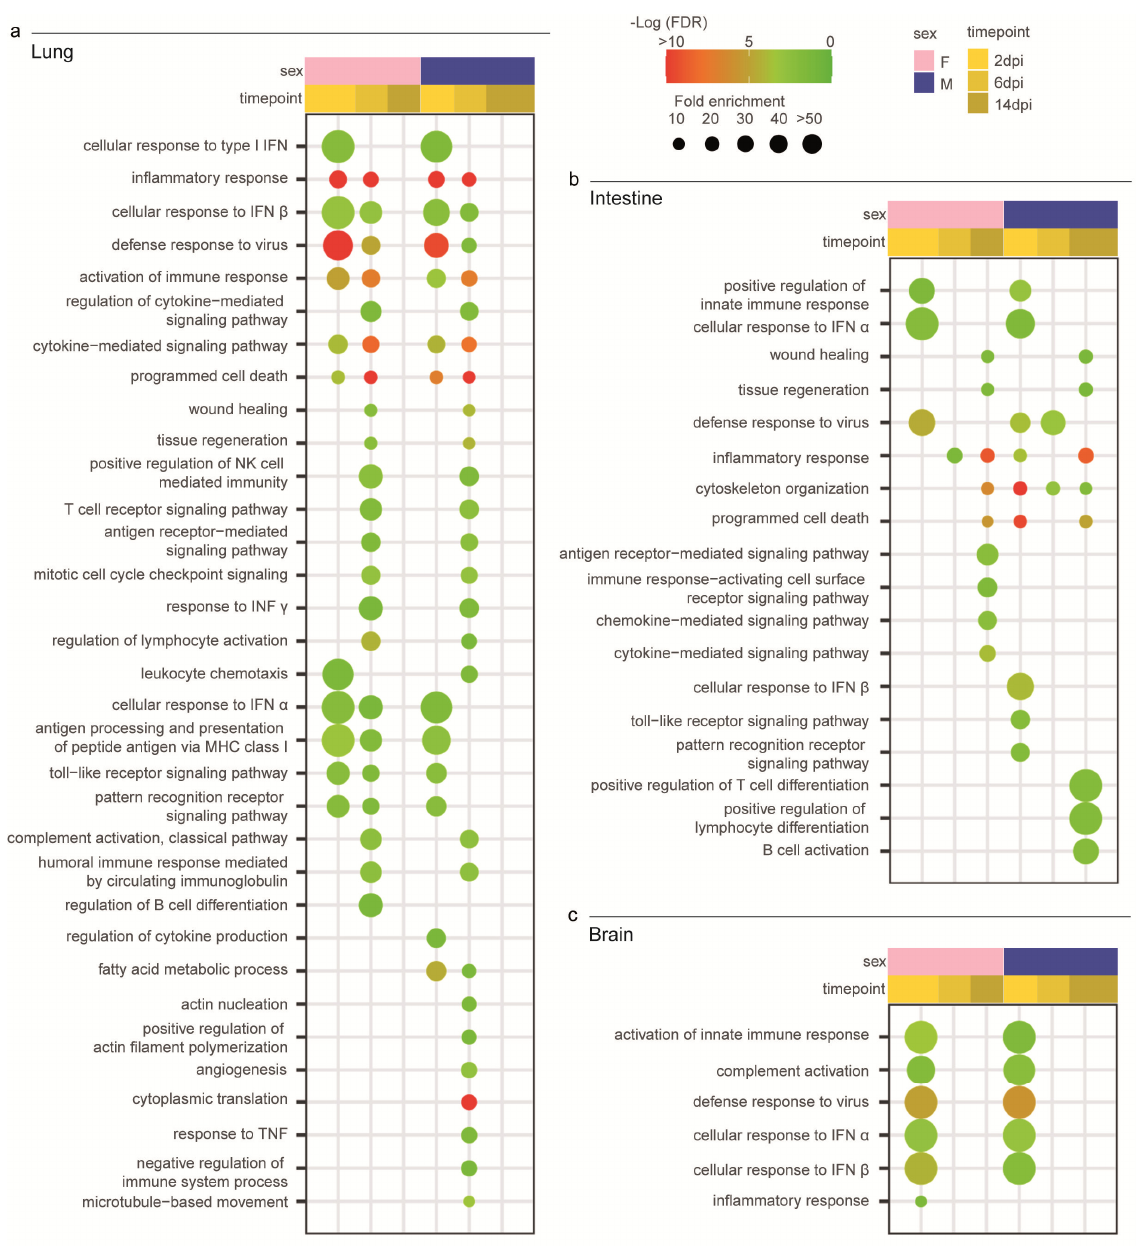
Figure 4. Transcriptomic profile of SARS-CoV-2-infected male and female Syrian hamsters. ( a ) Dotplot representing the most specific enriched Gene Ontology (GO) terms related to immunity in lungs. ( b ) Dotplot representing the most specific enriched GO terms related to immunity in intestines. ( c ) Dotplot representing the most specific enriched GO terms related to immunity in brains. Statistically significant enrichments (FDR < 0.05) are presented, and the − LogFDR is shown. The absence of the dot means that the indicated GO term was not enriched in that particular sample.